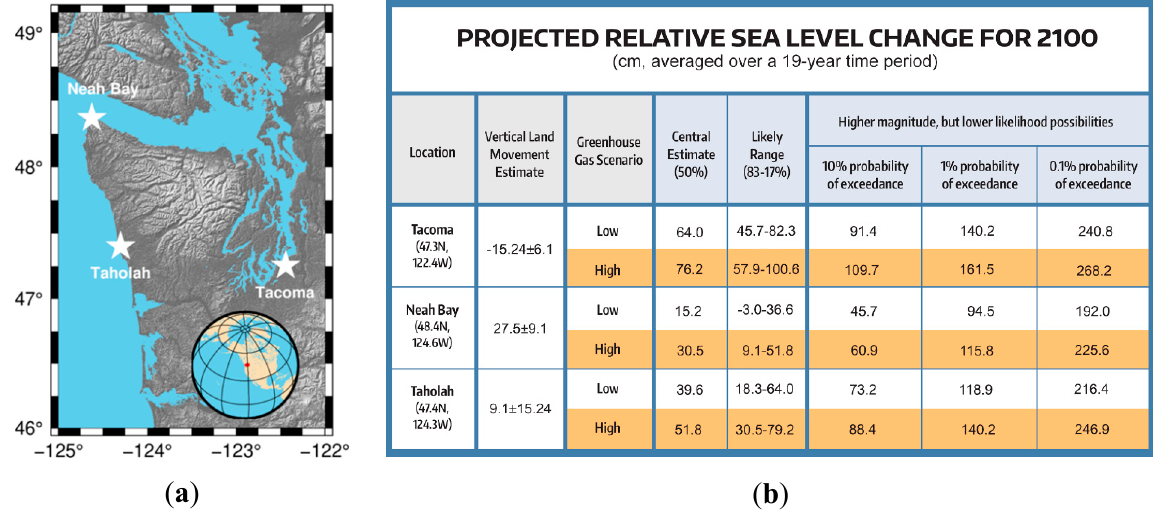
Figure 8. ( a ) Three coastal locations in Washington state discussed in: ( b ) table adapted from Miller et al. [28] showing relative sea level rise projections for 3 of 171 locations along coastal Washington. Projections are expressed in terms of the probability of exceedance for 2100 under two different greenhouse gas scenarios (RCP 4.5 [“Low”] and RCP 8.5 [“High”]; [40]). Projected changes are assessed relative to contemporary sea level, defined as the average sea level over the 19-year period 1991–2009. Projections for all 171 locations are available in [28].